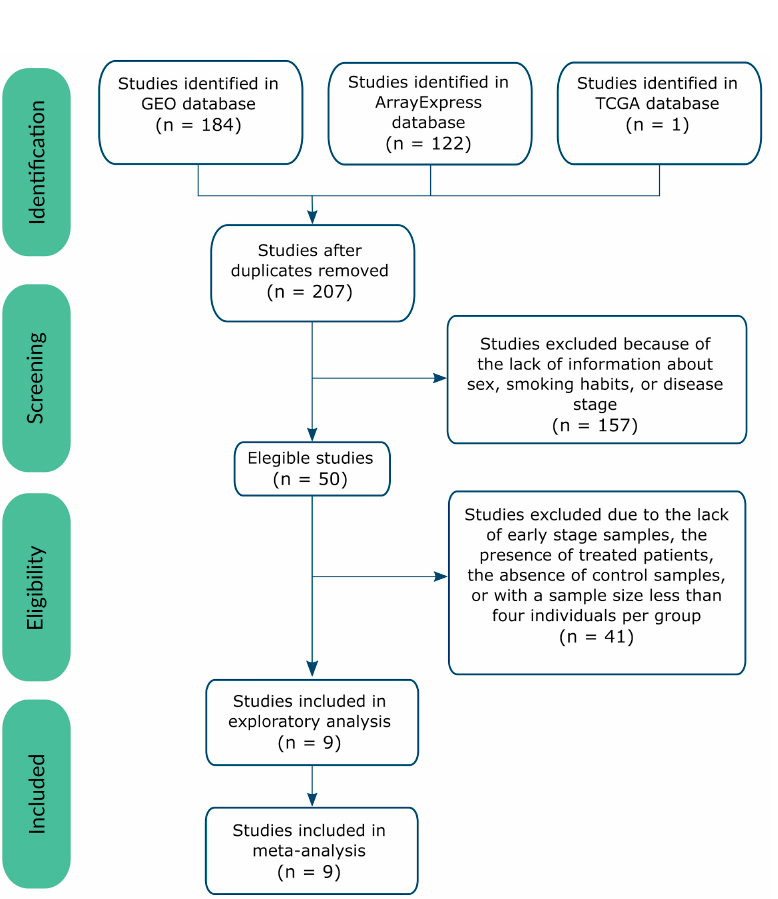
Figure 1. Flow of information through the different phases of the systematic review, following PRISMA Statement guidelines